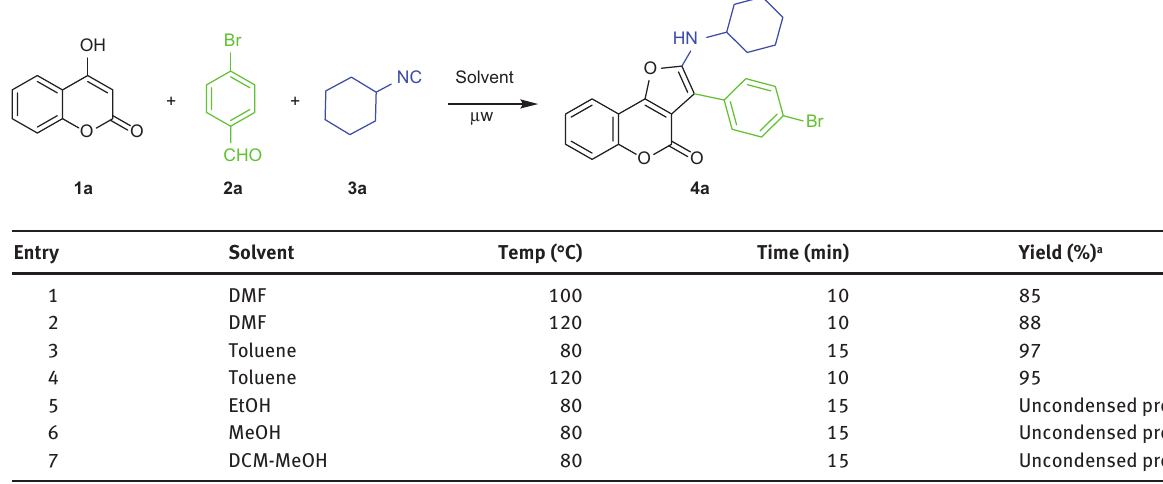
Table 1 Optimization of multicomponent reaction (MCR) for the synthesis of furocoumarin